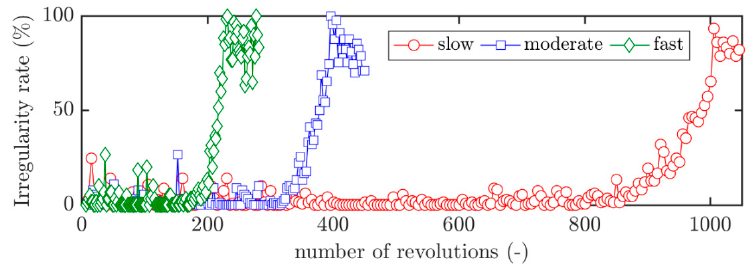
Figure 15. Evolution of the irregularity rate for three different throttling speeds.